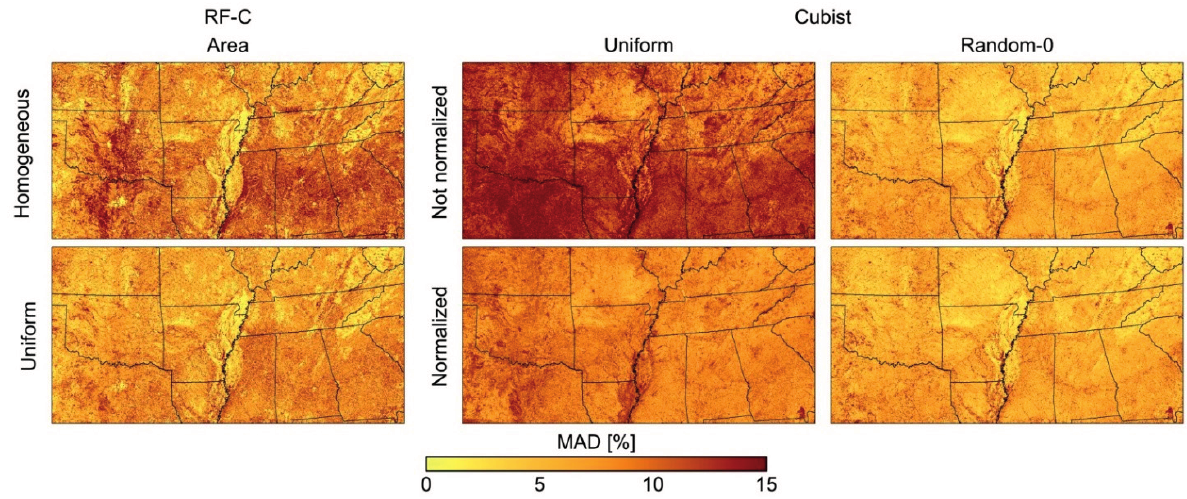
Figure 5. Spatial mean absolute difference (MAD) of selected image sets of class memberships. Random forest classification (RF-C) with area-proportional sample allocation between classes and homogeneous and heterogeneous, uniformly allocated training pixels. Cubist with uniform and random allocation of heterogeneous training pixels and with and without